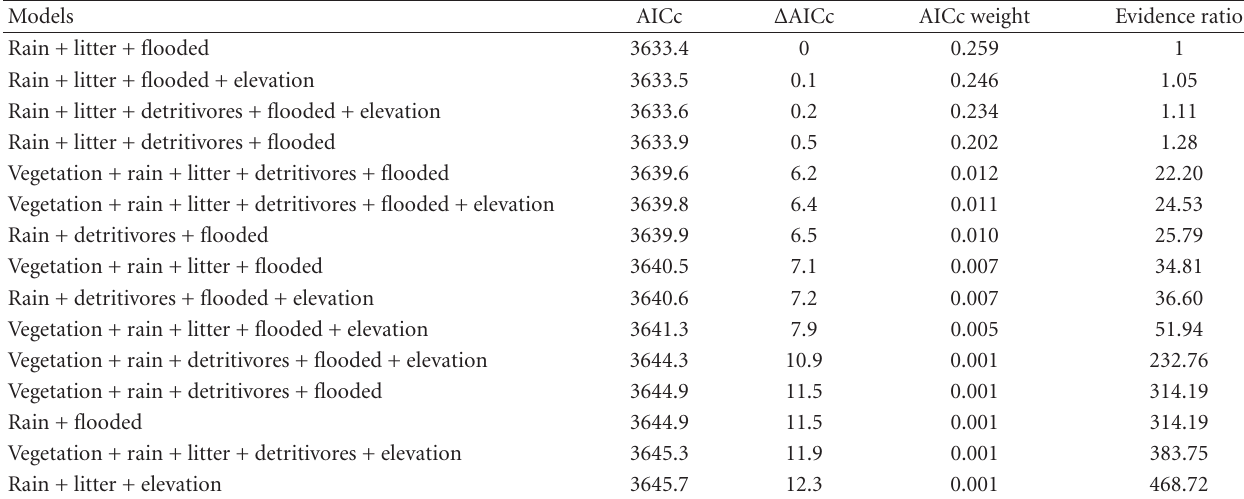
Table 4: Model selection for explaining scat decay rate during 36 weeks, all models were fitted with interval censored survival model with the 48 sites as frailty e ff ect.